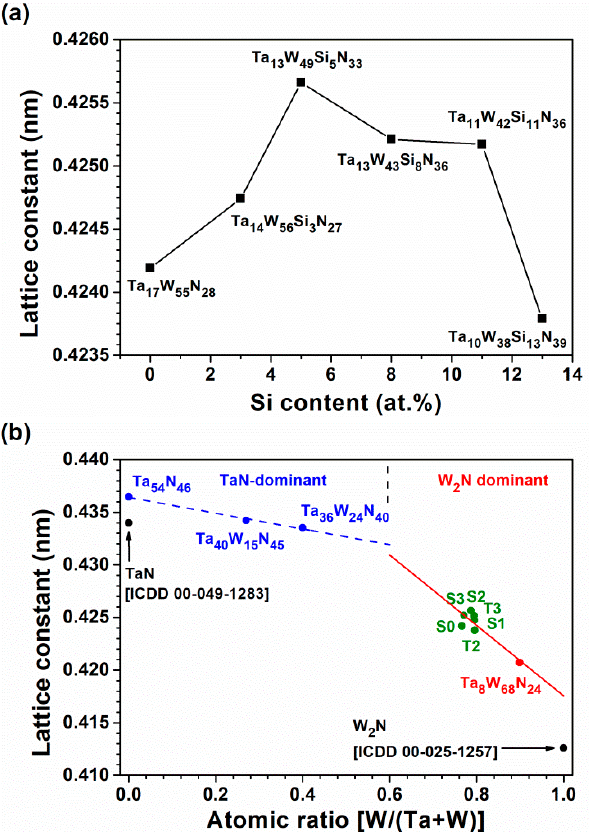
Figure 6. ( a ) Lattice constants of the TaWSiN films and ( b ) the relationship between lattice constants and the atomic ratio of W/(Ta + W) for TaWSiN and TaWN [14] films.